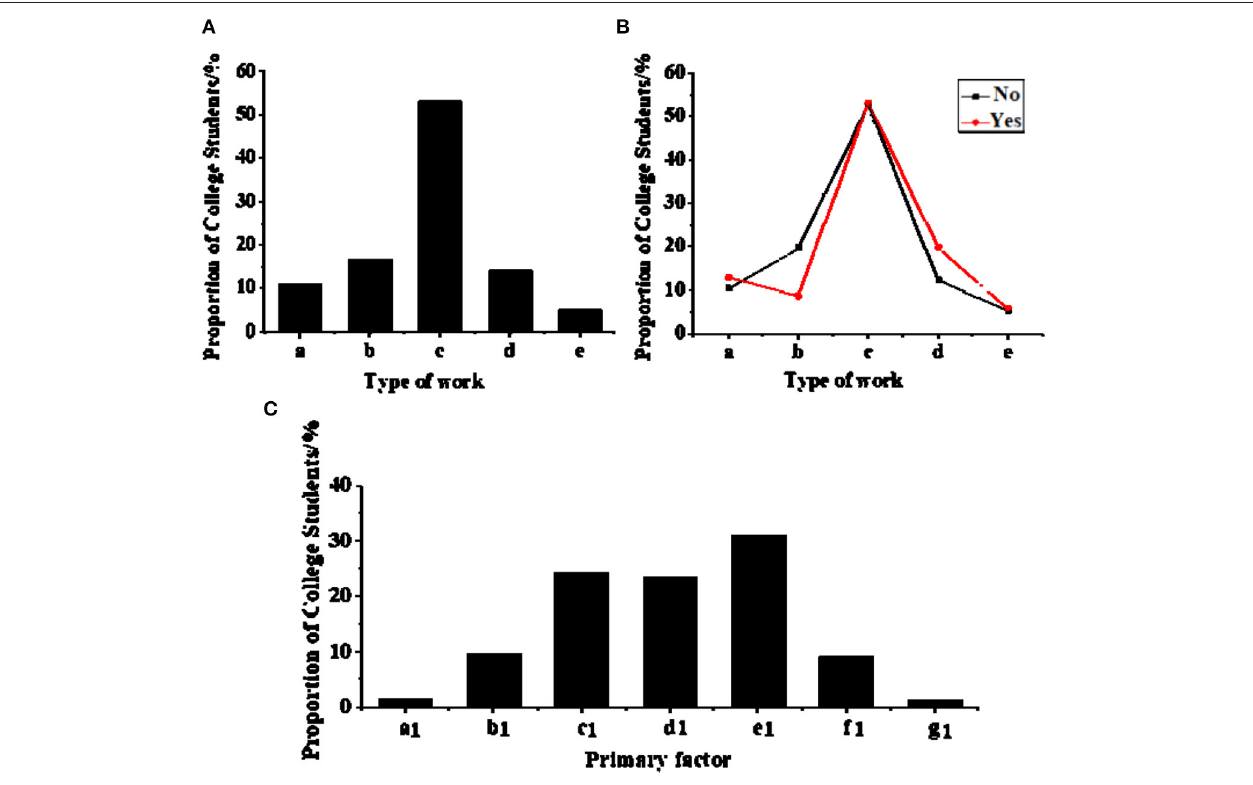
FIGURE 3 | Career choice and factors’ statistical analysis [ (A) . College students’ career choices. a. Party and government organs; b. Public institution; c. Company; d. Self-employed; e. Else (B) . Whether students have received innovation and entrepreneurship education when choosing a career. (C) . The primary factors in choosing a career. a1. Social needs; b1. Personal value realization; c1. Development space; d1. Personal interests; e1. Pay level; f1. Professional counterparts; g1. Else].